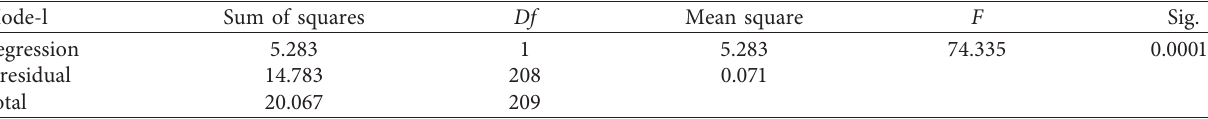
Table 5: ANOVA impact of BIM on planning (ANOVA a ).